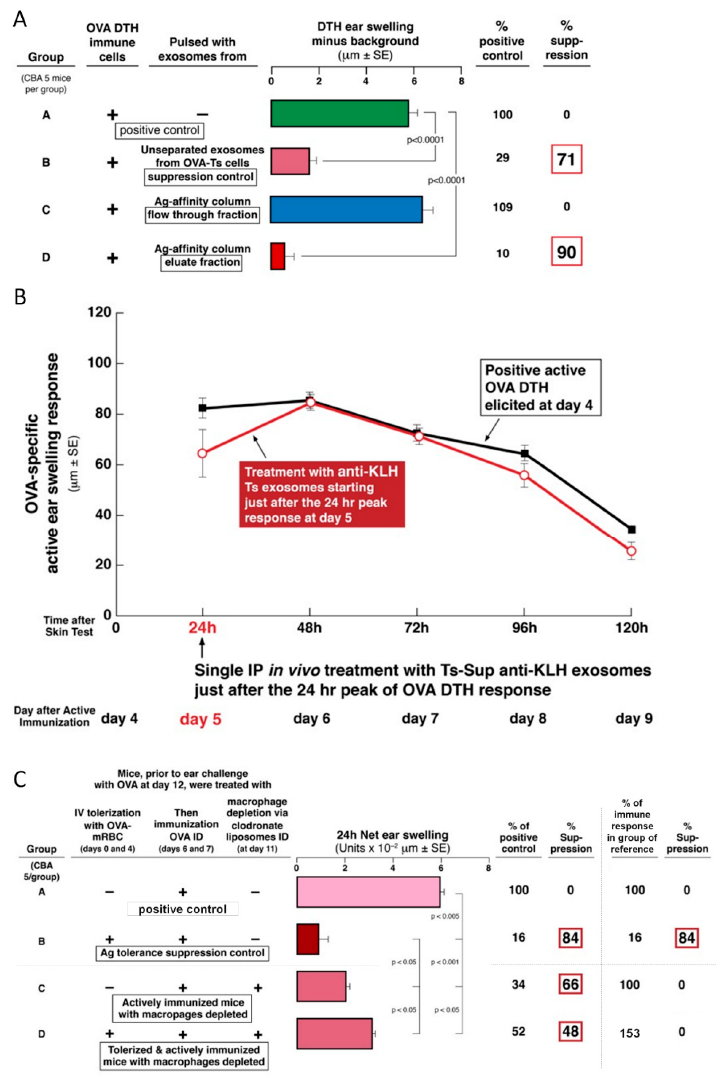
Figure 2. Ag specificity of suppressive exosomes shown by OVA Ag affinity chromatography and criss-cross Ag-testing, and the essential role of antigen-primed macrophages in tolerance induction. ( A ) OVA-induced DTH is suppressed only by exosomes present in the eluate of OVA Ag-affinity chromatography column separating the exosomes (Group D column eluate vs. Group C column flow through, 90% suppression vs. 0% suppression). ( B ) Ag specificity of suppressive exosome treatment employing analogous anti-KLH protein suppressor T cell exosomes from KLH Ag tolerized donors, that do not inhibit OVA DTH when given IP at the 24-h peak of the OVA-elicited DTH ear swelling response. ( C ) OVA-induced DTH cannot be suppressed by intravenous tolerization with systemic administration of high doses of OVA-linked syngeneic red blood cells in mice depleted of antigen-presenting macrophages (Group D vs. C). Results are shown as delta ± standard error (SE), one-way ANOVA with post hoc RIR Tukey test. n = 5 mice in each